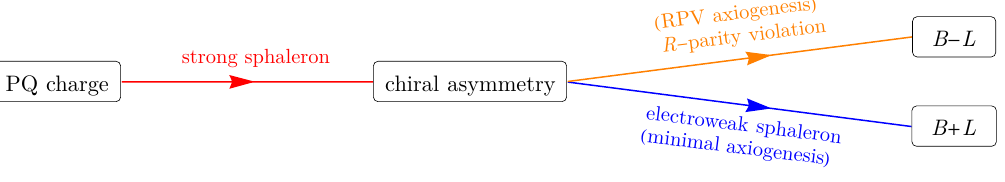
Figure 1 . Transfer of asymmetries for minimal axiogenesis and RPV